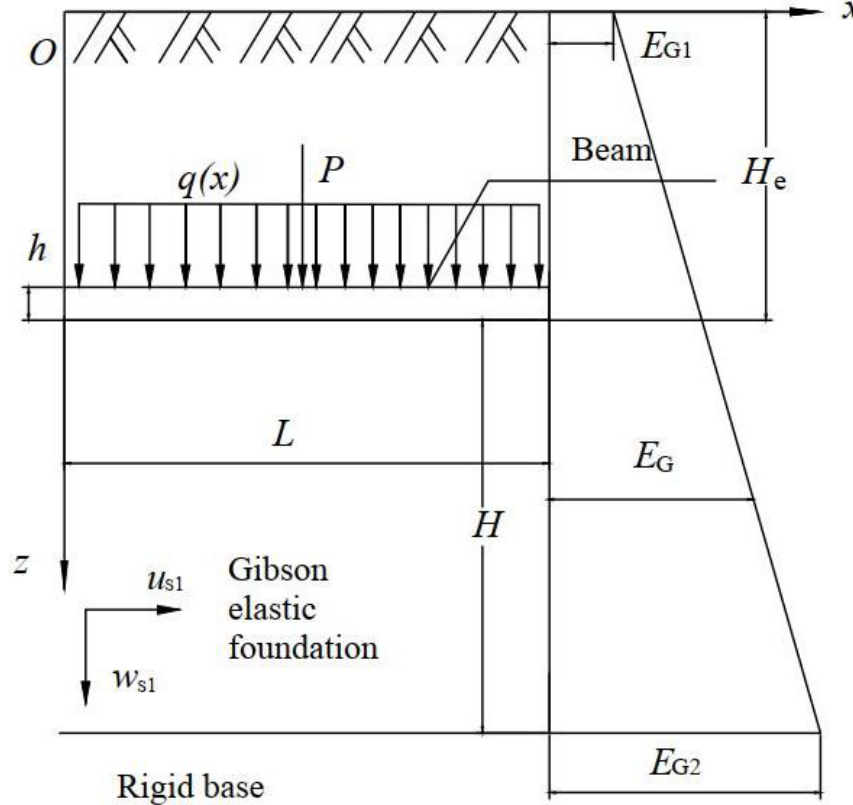
Figure 1. A finite-length beam embedded in a Gibson elastic foundation.